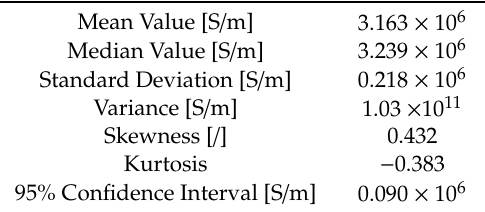
Table 4. E ff ective electrical conductivity results and statistical analyses for a silver / epoxy nanocomposite with a particle size of 3 nm, tunneling distance of 1.5 nm, and 30 vol% filler loading.